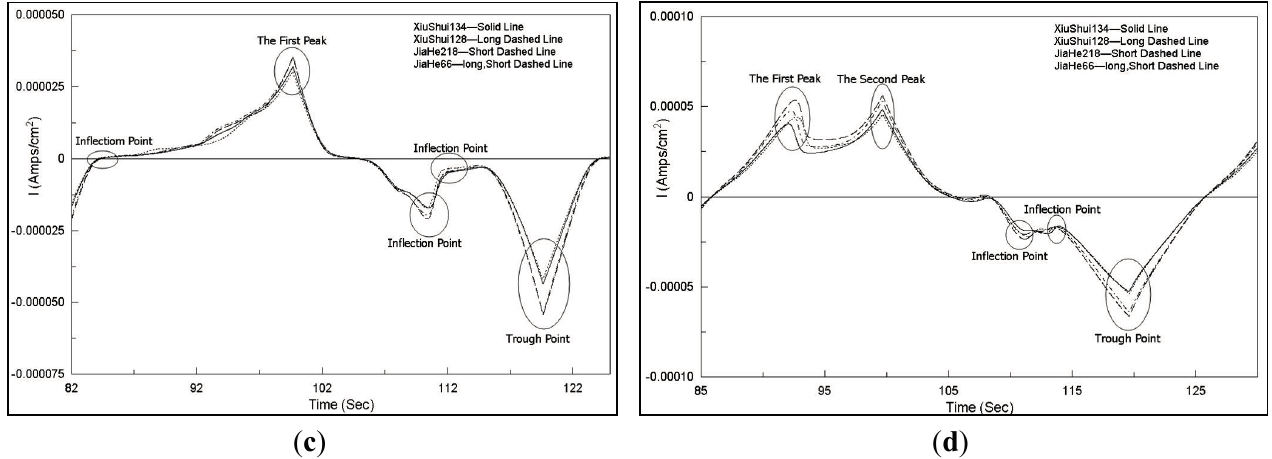
Figure 4. Current-time amplified charts of four working electrodes obtained with one time data collection for four non-crushed rice sample solutions. ( a ) Pt electrode; ( b ) Ag electrode; ( c ) Au electrode; ( d ) Pd